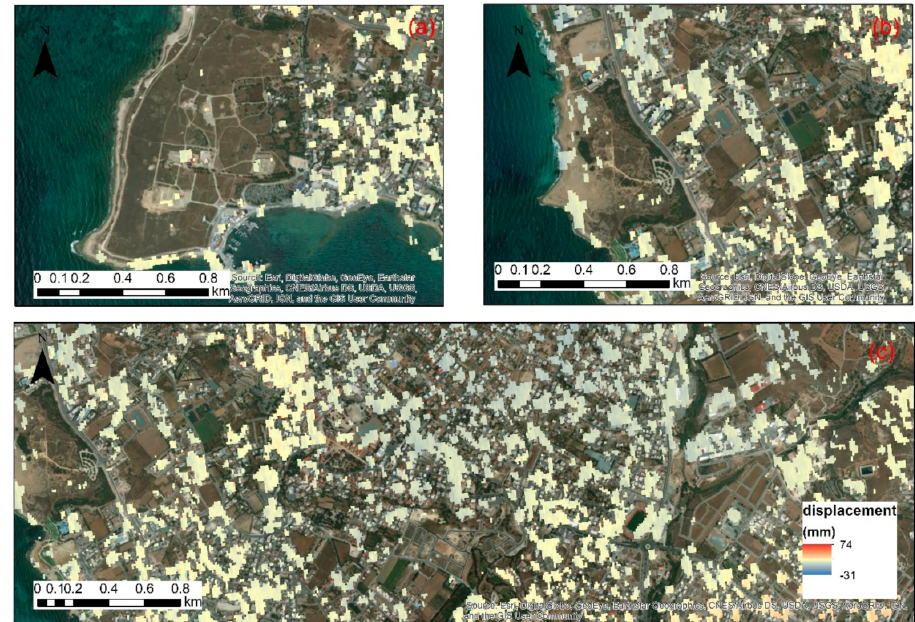
Figure 5. Final displacement map at ( a ) Nea Paphos; ( b ) “Tombs of the Kings”; and ( c ) historic center of